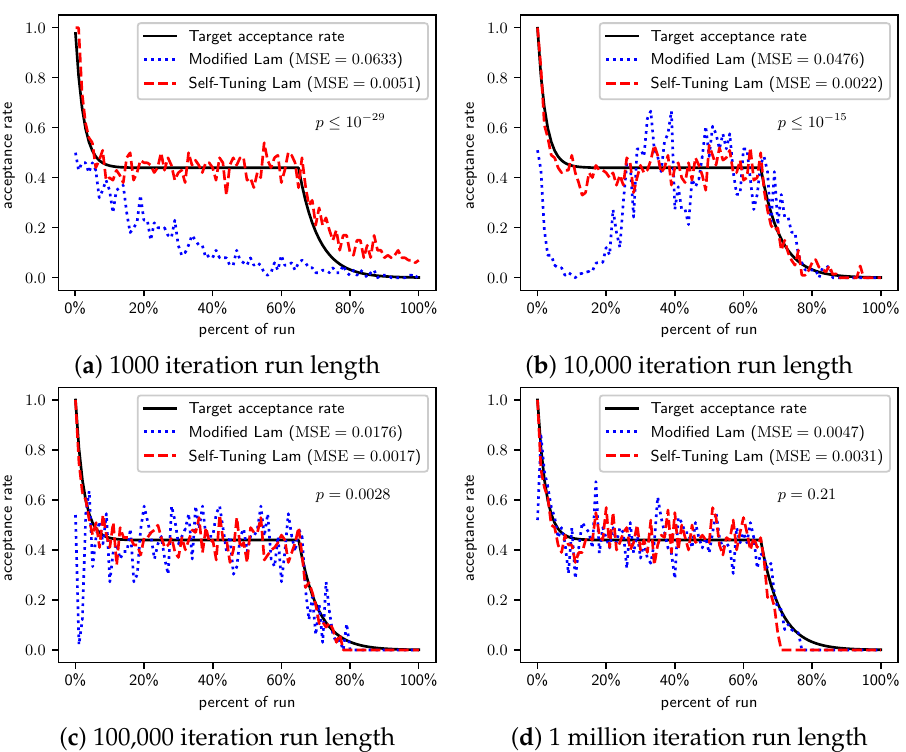
Figure 3. OneMax (each 0-bit costs 10): Self-Tuning Lam, Modified Lam, and target acceptance rates for ( a ) 1000 iterations, ( b ) 10,000 iterations, ( c ) 100,000 iterations, and ( d ) 1 million iterations.